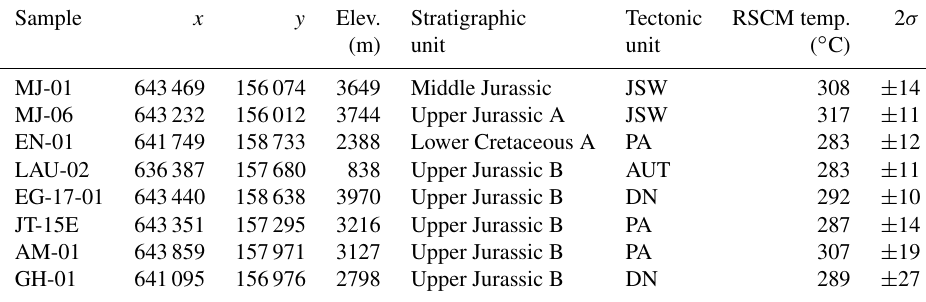
Table 3. RSCM temperature estimation for peak metamorphic temperature; PA: para-autochthonous sediments, DN: Doldenhorn nappe, AUT: autochthonous sediments. Coordinates are given in the Swiss coordinate system